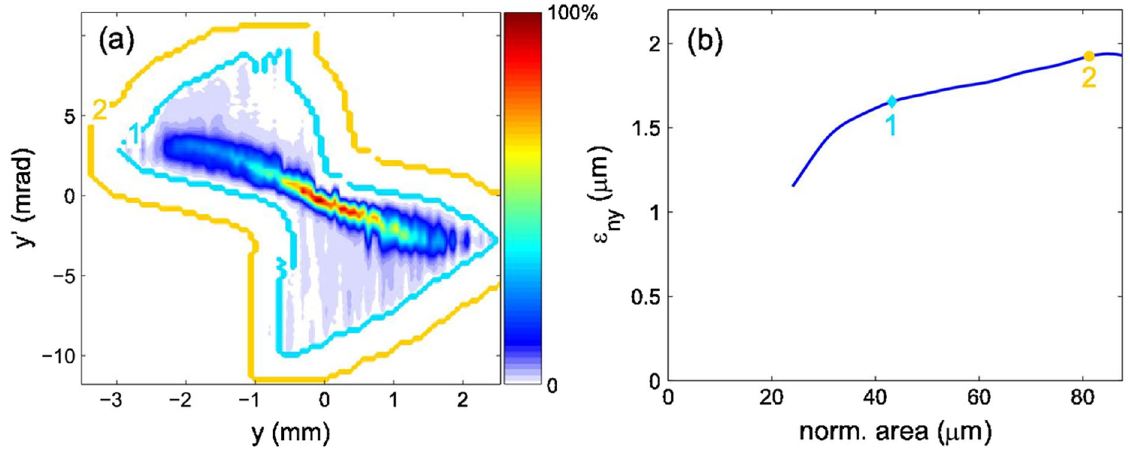
FIG. 12. (Color) Noise subtraction verification procedure. (a) Example transverse phase space with the contour (1) obtained through the boundary detection algorithm and the grown contour (2), which corresponds to 50% of the available data treated as noise. (b) Normalized rms emittance calculation as a function of included area after the noise subtraction. Refer to the text for details.